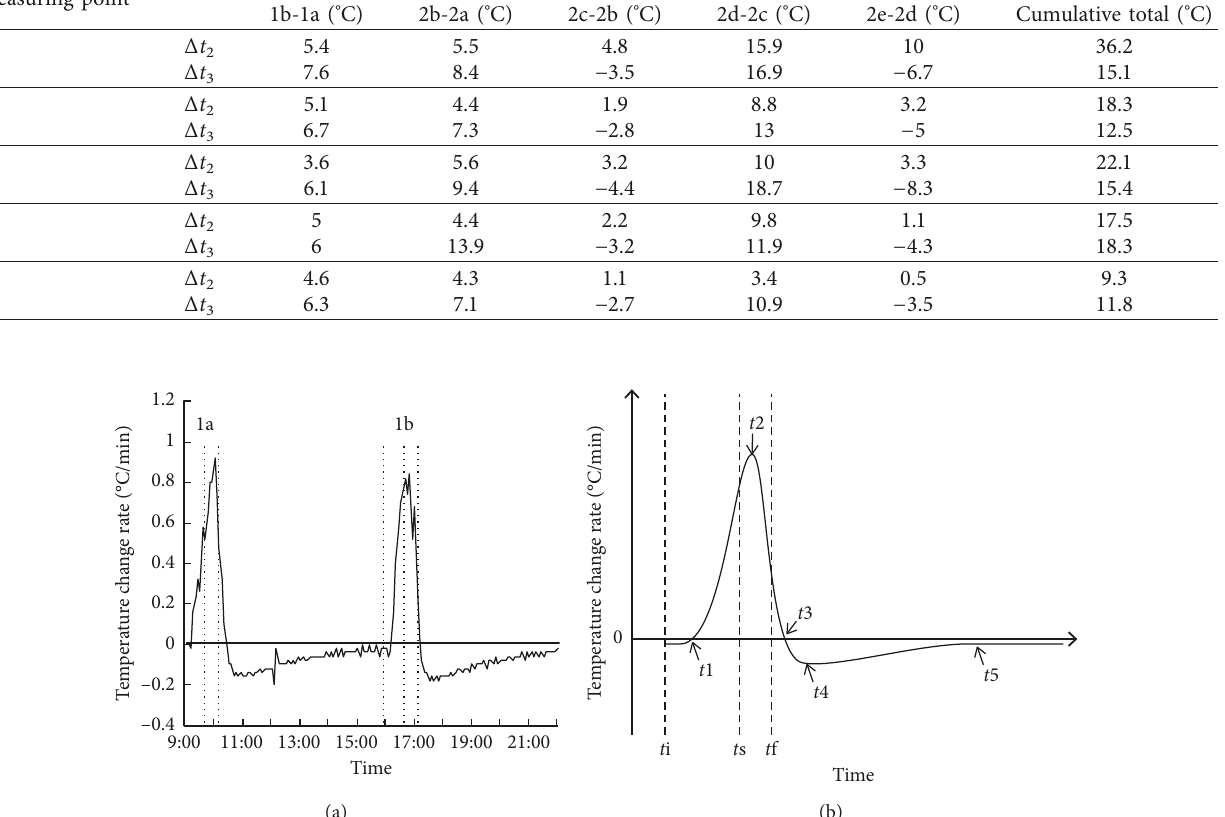
Table 4: Peak ( Δ t 2 ) and initial temperature differences ( Δ t 3 ) of the heated wall surface. Measuring point